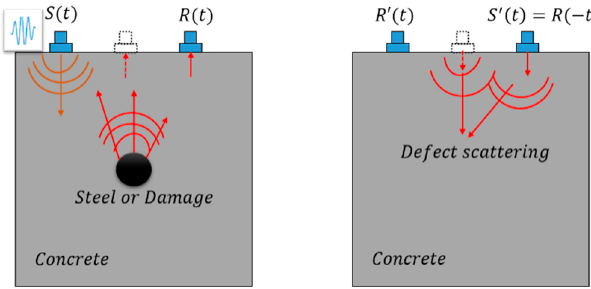
Figure 4. The concrete time reversed method detecting system.